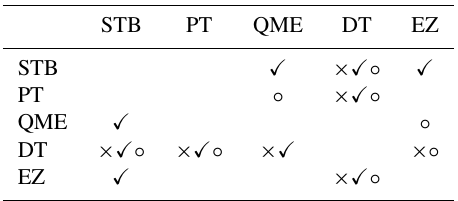
Table 3. ANOVA post hoc tests for the results of the five bias- correction schemes ( p< 0 . 05). The checklist table gives an indi- cation (symbol) where two bias-correction schemes’ results are sig- nificantly different from each other. Where there is no symbol, it means that the schemes’ results are not significantly different. The different symbols represent the Upper, Middle, and Lower Zambezi basins.